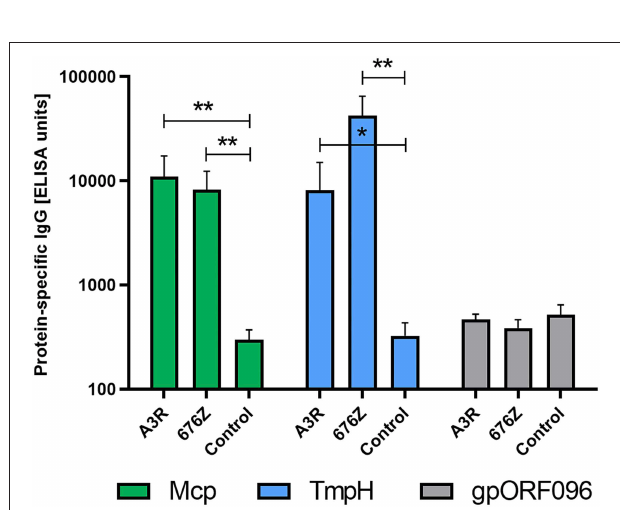
FIGURE 3 | Individual immunogenicity of three selected structural proteins of phages A3R and 676Z in mice treated with the phage per os assessed by IgG ELISA units. Mice ( N = 6) were administered purified preparations of phages A3R or 676Z in drinking water mixed with PBS to a final concentration of 4 × 10 9 pfu/ml. Phage-enriched drinking water was administered as a sole water source continuously for 100 days. Separated plasma samples from these mice were examined for IgG antibodies specific to selected structural proteins: Mcp, TmpH, and gpORF096. Results were normalized and ELISA units were calculated with regard to a standard curve obtained for OVA-coated wells and OVA-specific murine serum (41, 48, 49). Statistically significant differences between groups are marked with asterisks: * p < 0.008, ** p < 0.005 (one-tailed Mann-Whitney U -test).